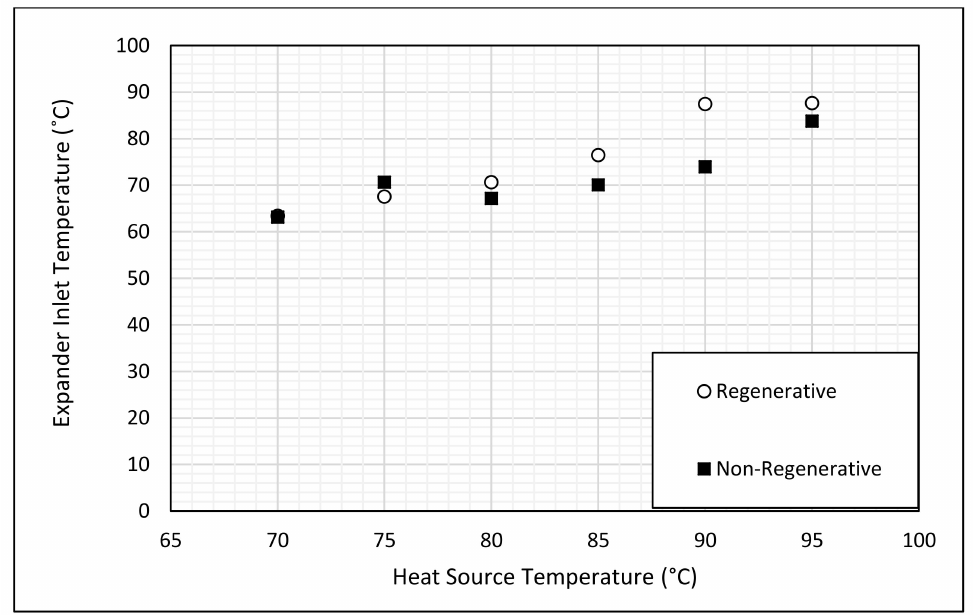
Figure 7. Variation in expander inlet temperature with changing heat source